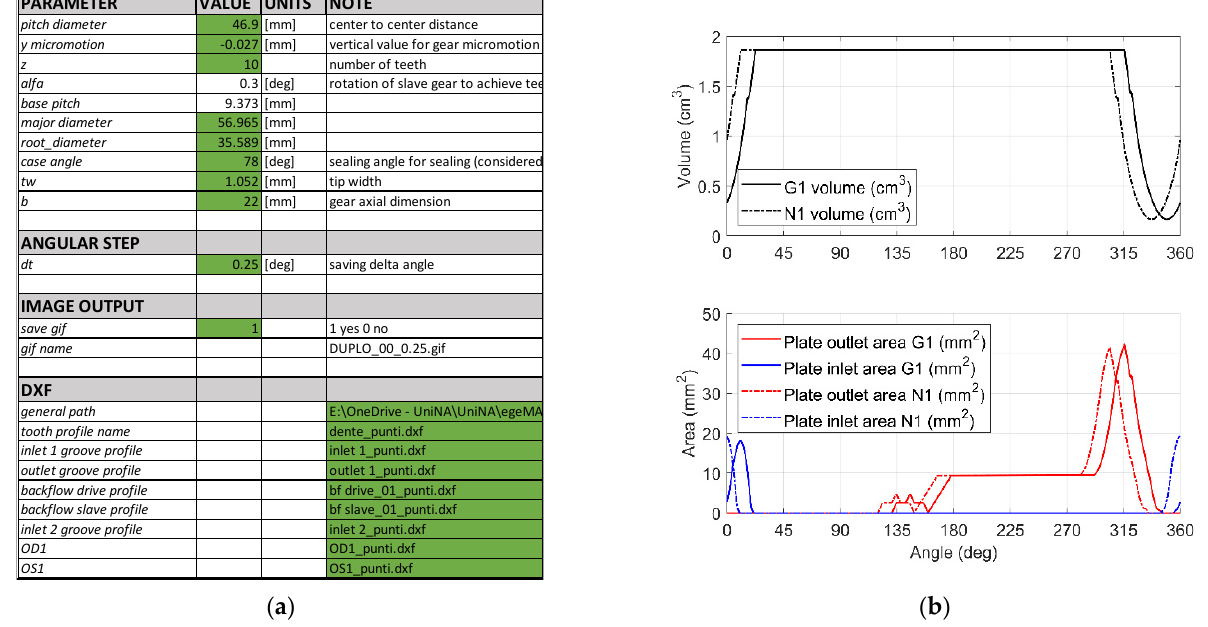
Figure 3. The Surface Tool: ( a ) Excel sheet input sample for the Surface Tool input; ( b ) Sample of output data. To provide support for the user, helping to visualize the morphology of the displace- ment chambers and their connections with the wear-plates, the Surface Tool is also capable ing. The GIF animation frames have been presented in Figure 4 for two different